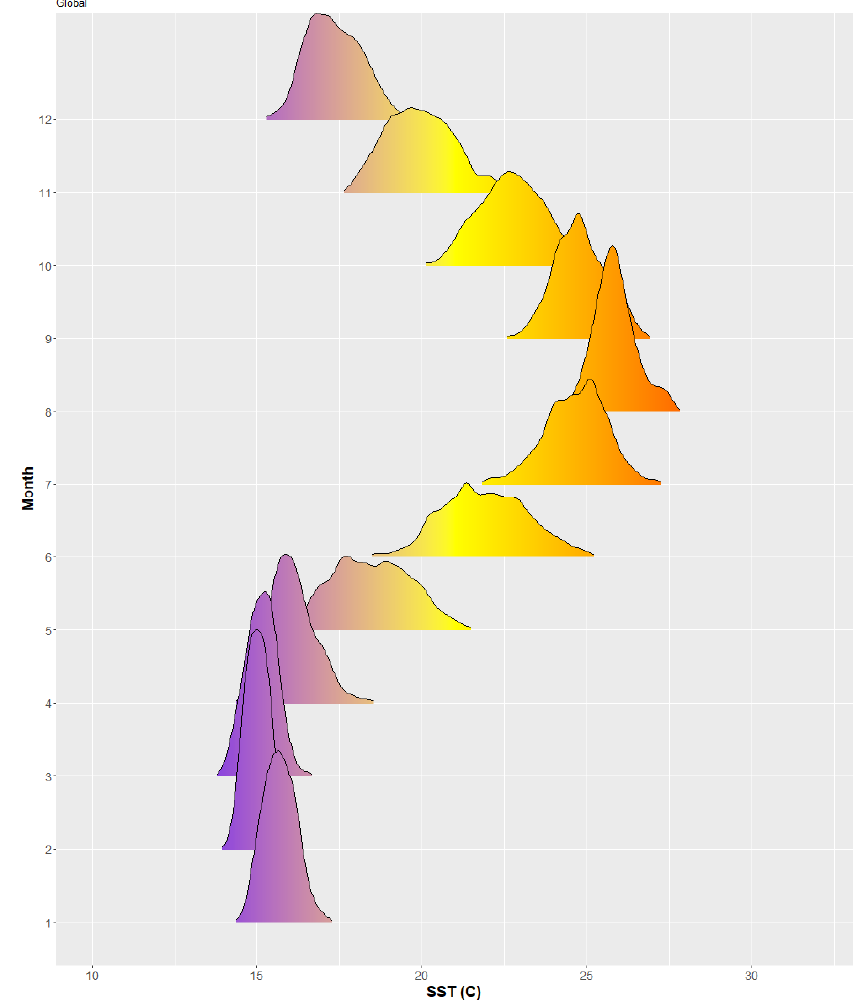
Figure 2. Monthly density plot for the mean Mediterranean SST. Remote Sens. 2020 , 12 , x FOR PEER REVIEW